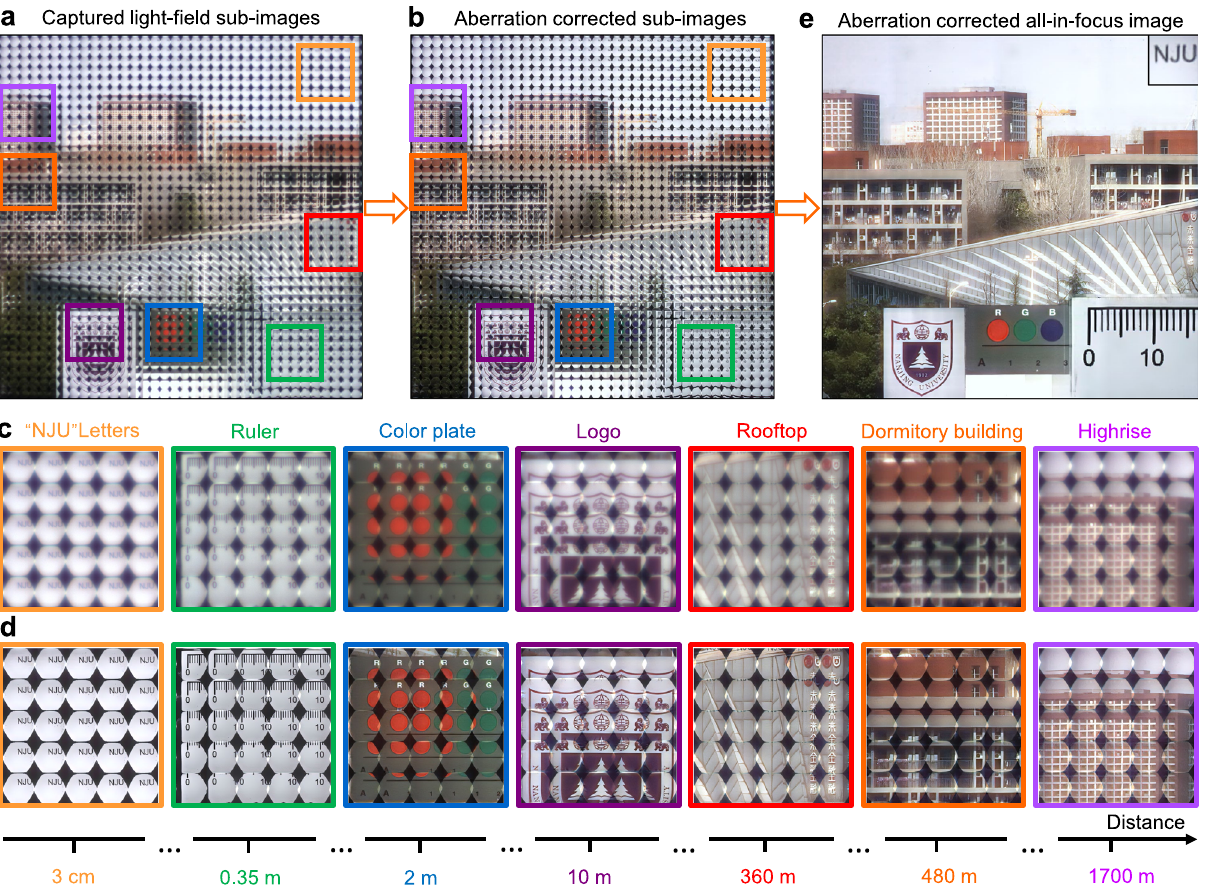
Fig. 6 Experiment results of the light- fi eld imaging with extreme DoF. a , b Captured light- fi eld subimages of the whole scene under natural light ( a ) before and ( b ) after aberration correction. c , d Zoomed-in subimages of different objects corresponding to the marked ones shown in ( a , b ), respectively. e Aberration-corrected all-in-focus image after rendering. The reconstructed NJU characters have been reasonably shifted and scaled for easy